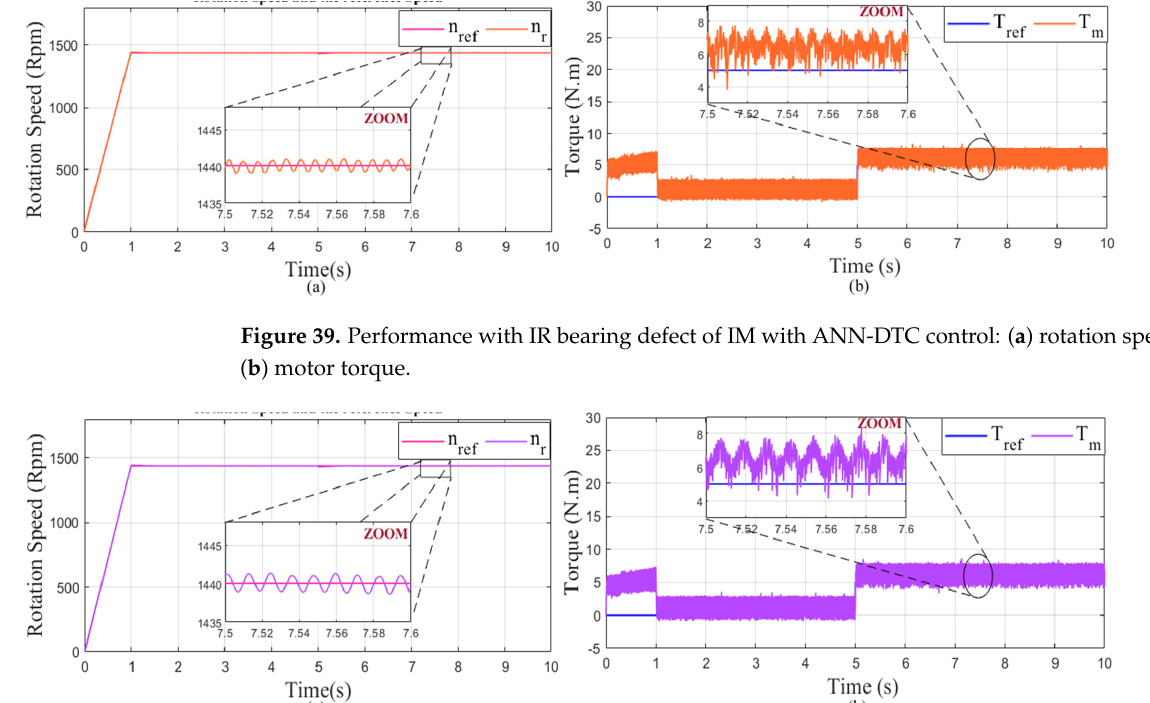
Figure 40. Performance with OR bearing defect of IM with ANN ‐ DTC control: ( a ) rotation speed and ( b ) motor torque.